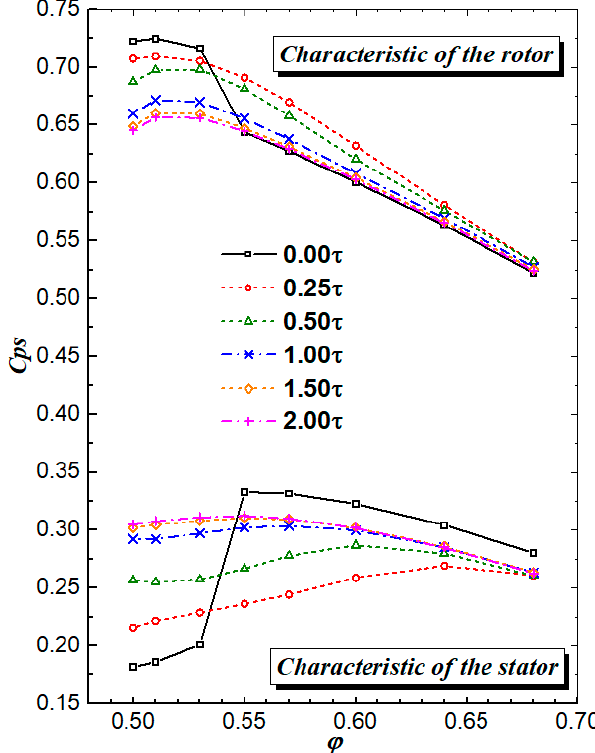
Figure 18. Static pressure rise characteristics of the stator and the rotor.